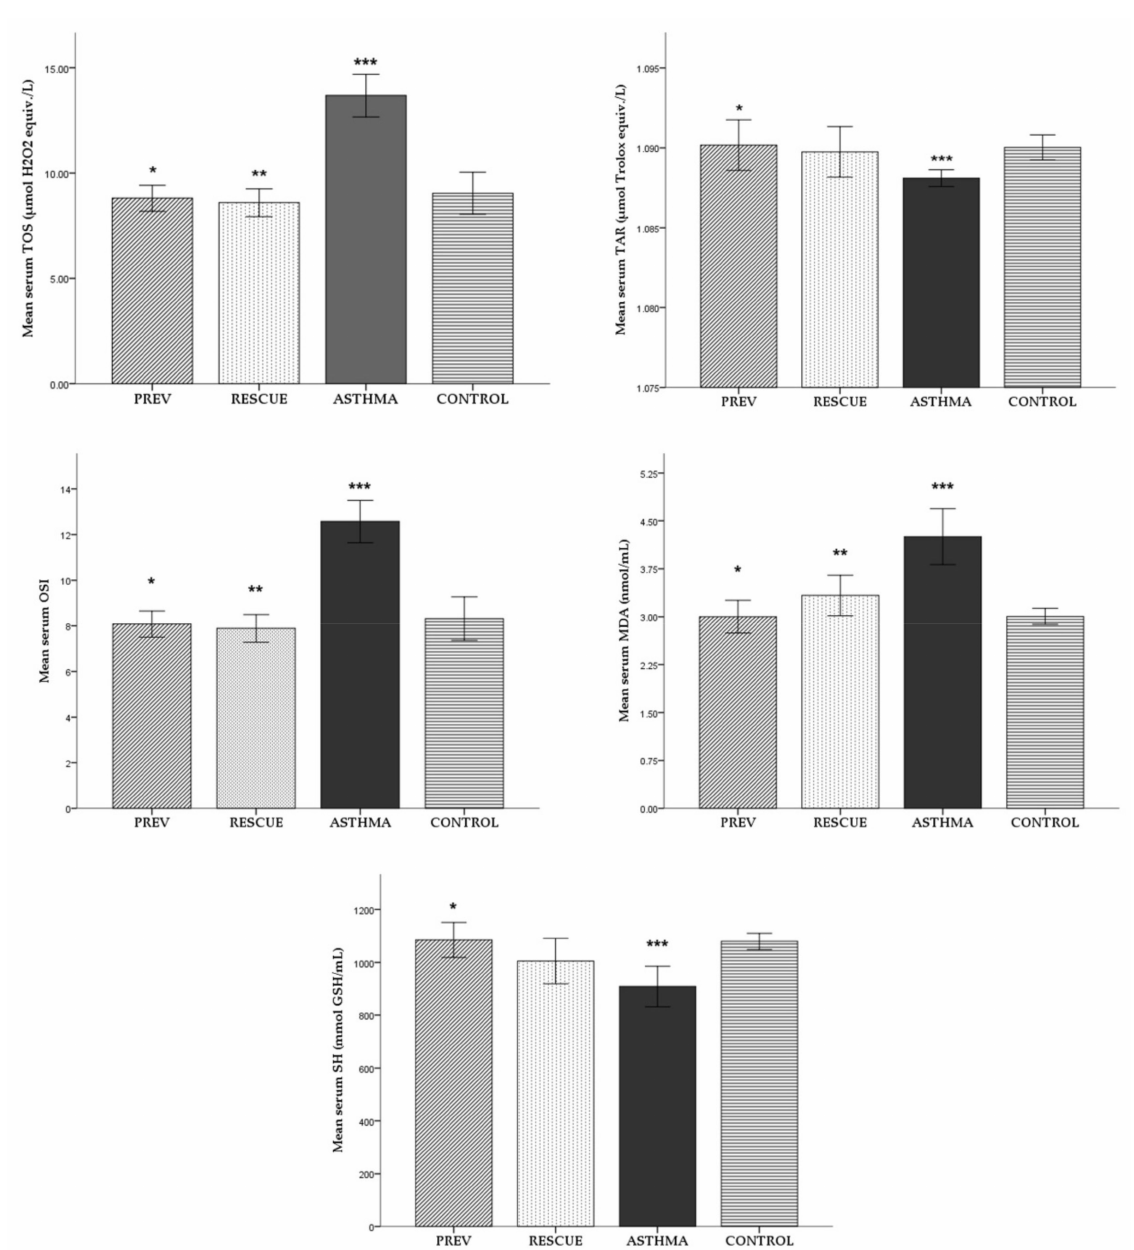
Figure 1. Mean levels ( ± standard deviation) of oxidative stress parameters in serum. Comparison between experimental groups: * p < 0.05 PREV versus ASTHMA group; ** p < 0.05 RESCUE versus ASTHMA group; *** p < 0.05 ASTHMA versus CONTROL. Abbreviations: TOS = total oxidative status, TAR = total antioxidant response, OSI = oxidative stress index, MDA = malondialdehyde, SH = total thiols; PREV = long-term low-dose vitamin D supplementation, RESCUE = short-term high-dose vitamin D supplementation, ASTHMA = positive control, CONTROL = negative